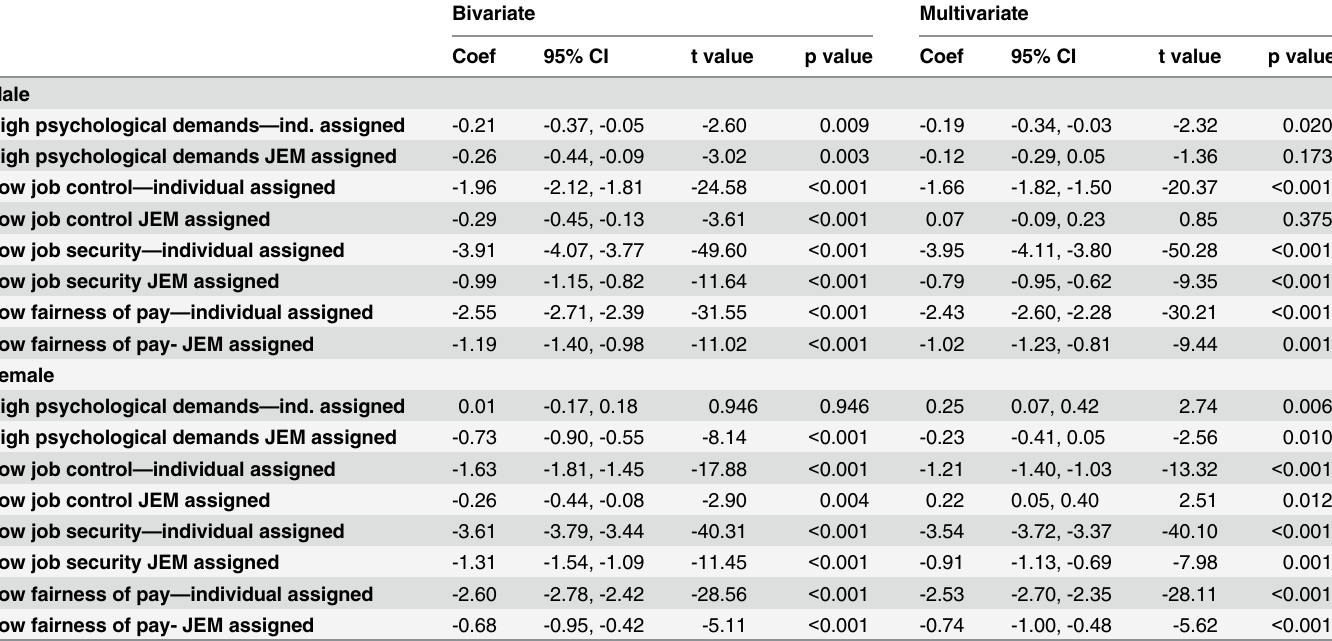
Table 3. Bivariate and multivariate associations of binary exposures with the Mental Health Summary (MCS) score, at the four digit level, results from a linear regression model, measured at the time of an individuals ’ first entry into the HILDA survey (people =